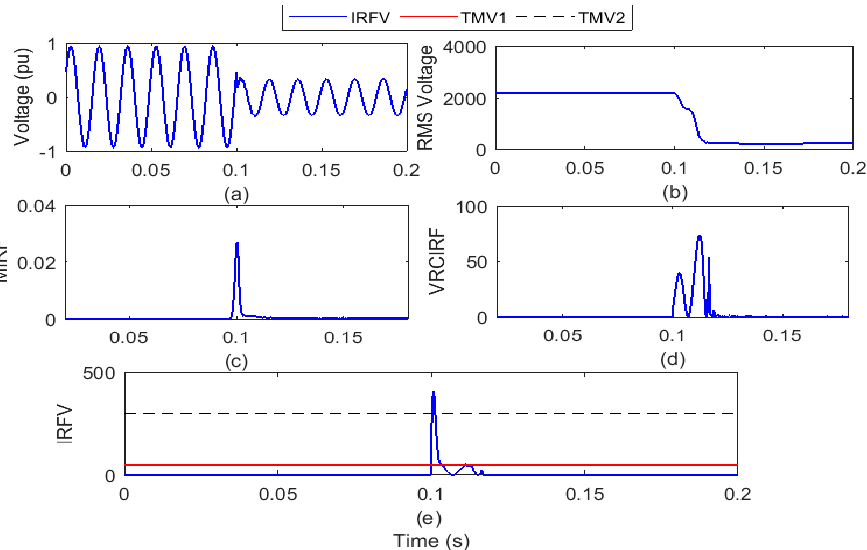
Figure 10. Three-phase fault with ground ( a ) voltage signal ( b ) root means square value of voltage ( c ) median-based IRF ( d ) rate of change in voltage-based IRF ( e ) islanding recognition factor based on voltage.